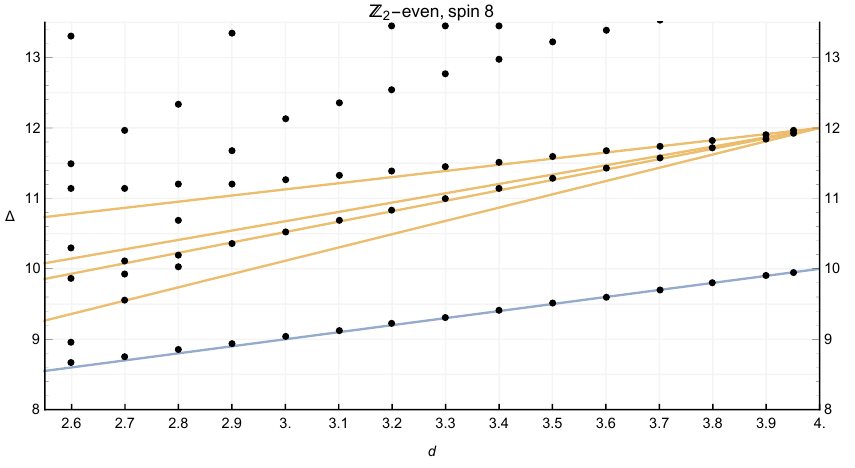
Figure 8 . Z 2 -even operators of spin